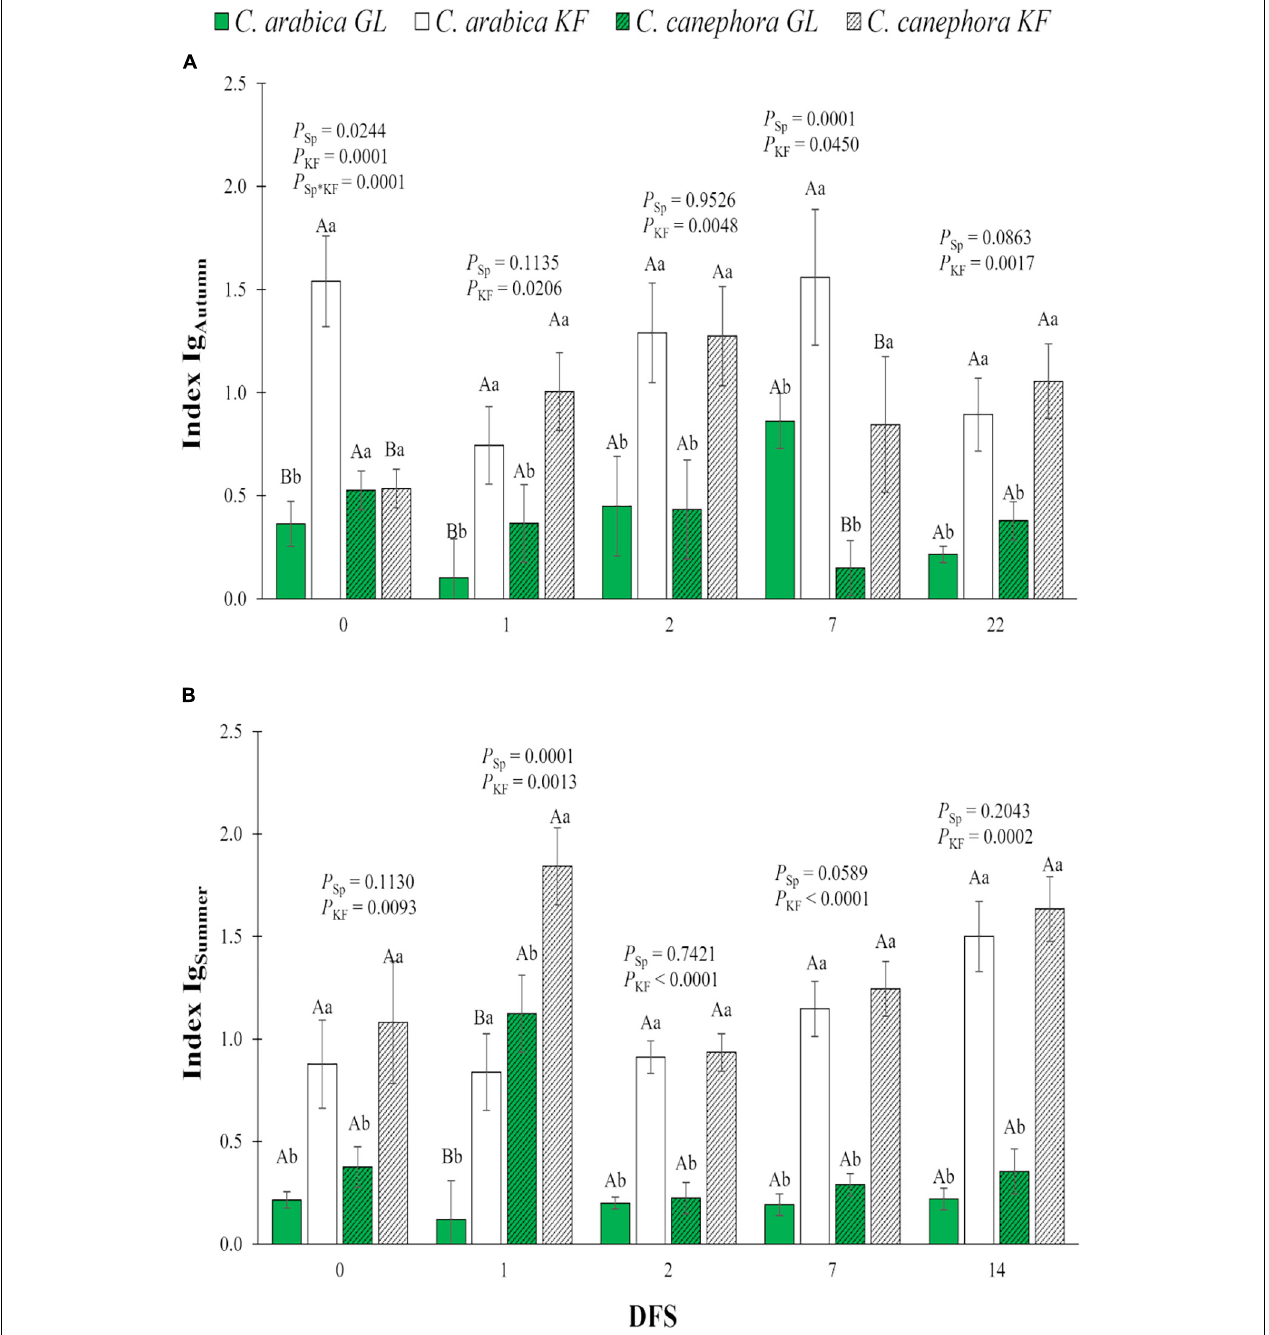
FIGURE 4 | Index of relative stomatal conductance (I g ) in young plants of two species (Sp.), Coffea arabica and C. canephora , protected with kaolin film (KF) and not protected (GL), during transference of coffee seedlings from the nursery to full sunlight in (A) autumn (I gAutumn ) and (B) summer (I gSummer ). Means ± S.E. followed by different lowercase letters indicate statistically different values between kaolin treatments within the same species, while uppercase letters indicate differences between two coffee species within the same kaolin treatment, detected by the ANOVA and Tukey test ( n = 5). P -values for effects of species kaolin and their interactions are indicated for days of exposure to full sunlight